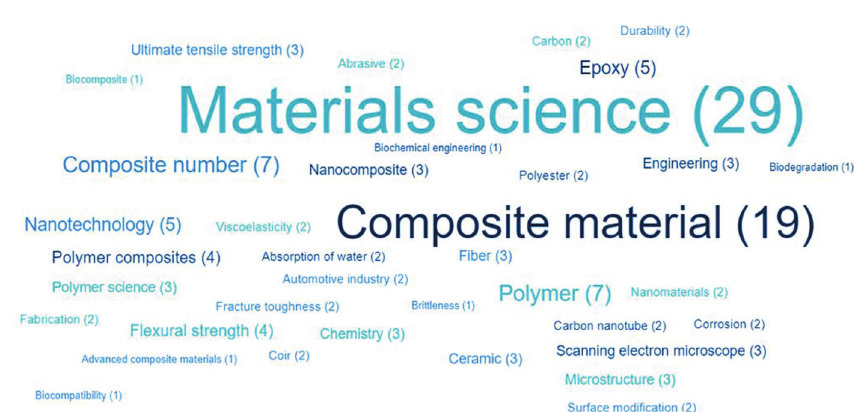
Figure 2: Unigraphics visualization showing the keywords facet on the influence of surface modifications and compatibilizers on the natural fiber-reinforced polymer composites.